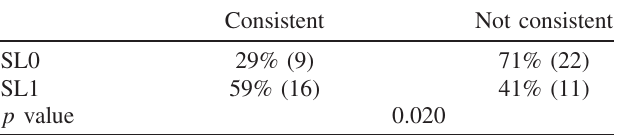
TABLE III. Percentages (and numbers) of students from the SL0 and SL1 groups who were consistent in all regions, and the p value for comparison between the groups via a chi-squared